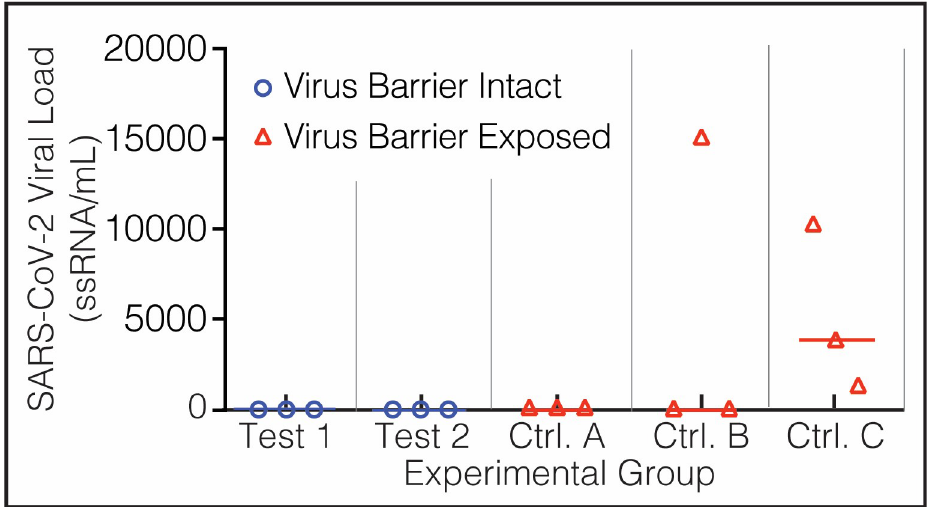
Fig 8. Biosafety data. Experimental evaluation of the devices used to contain SARS-CoV-2 specimens. After testing negative for SARS-CoV-2 in saliva, 5 groups of 3 golden Syrian hamsters each ( Mesocrisetus auratus ) were exposed during 4 days to SARS-CoV-2 directly (Group B, virus control) or enclosed in devices 1 and 2. Animals in Test groups 1 and 2 (blue circles) were allowed to sniff their devices but could not touch them, while those allocated to control groups A, B, and C (red triangles) had direct access to the containment fabric. The ordinate represents the viral load in saliva of each hamster after exposure to SARS-CoV-2 in 5 experimental groups.